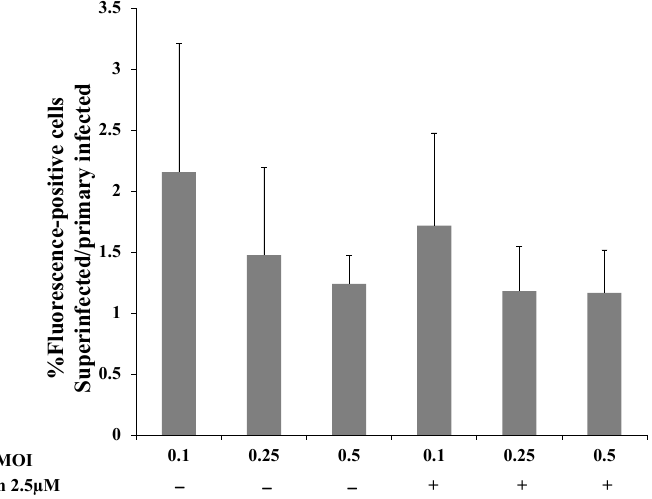
Figure 9. Aphidicolin treatment does not affect expression of the fluorescent marker of the incoming virions. Uninfected and latent BAC16-mCherry or BAC16-mNeonGreen-infected iSLK cells were either left untreated or treated with 2.5 µ M aphidicolin (Aph) 1 h prior to infection, and infected with BAC16-mNeonGreen or BAC16-mCherry viruses at MOI of 0.1, 0.25, or 0.5 with or without aphidicolin using spinoculation. After 48 h, the cells were harvested and the percentages of cells expressing mNeonGreen and mCherry were measured by FACS. The ratios between the percentage of cells expressing the incoming virion’s fluorescent protein in superinfected and primary infected cells are presented. Results shown are averages of four independent experiments. Statistical analysis was performed using a two-way ANOVA test and differences +/ − aphidicolin are not significant.